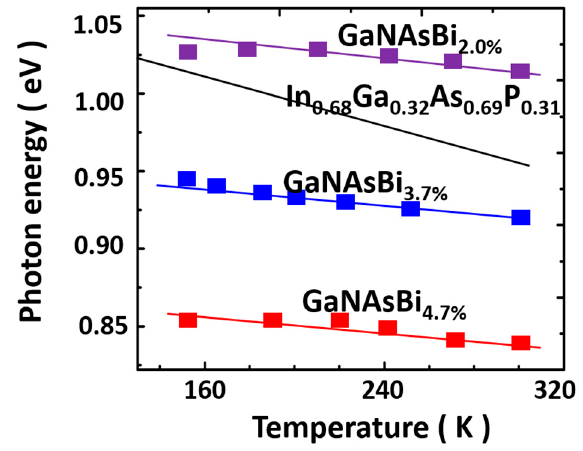
Figure 16. PL peak energy of GaNAsBi and In 0.68 Ga 0.32 As 0.69 P 0.31 as a function of measured temperature. Reproduced from Reference [134].